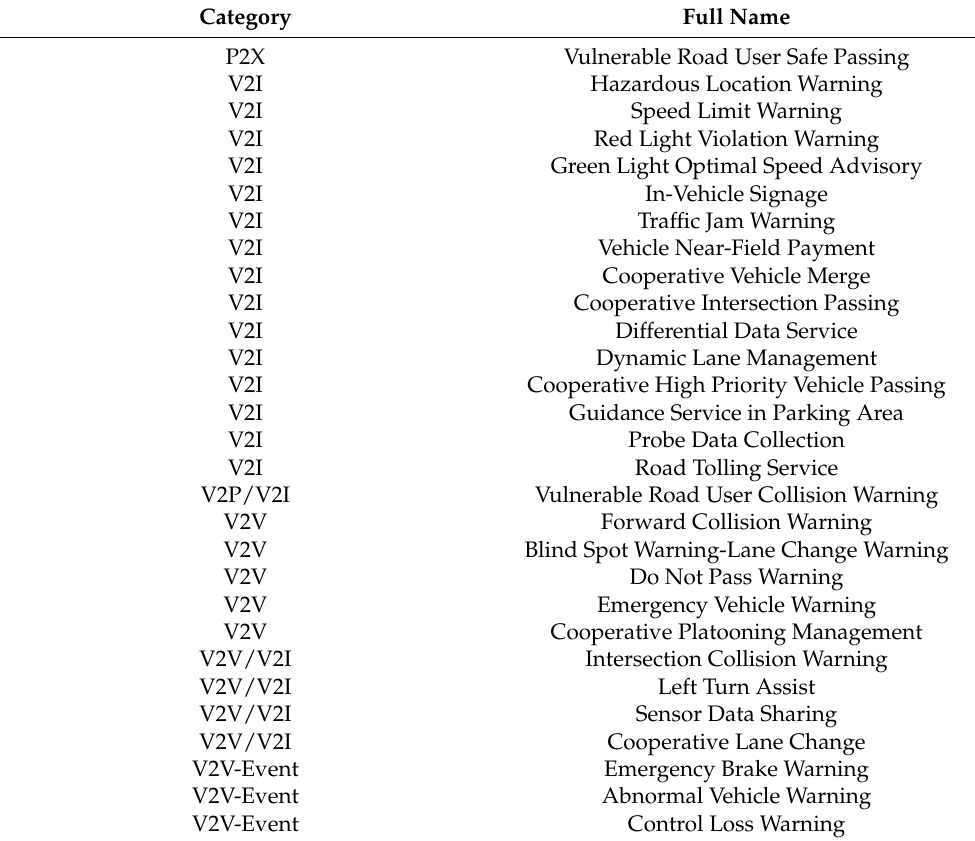
Table 1. V2X functionality test